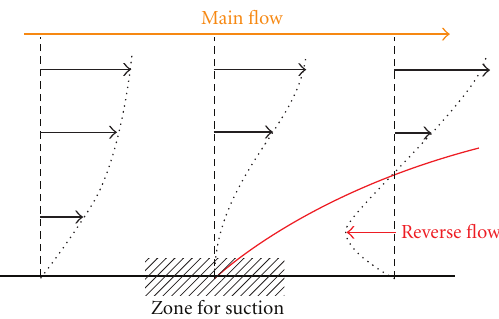
Figure 15: Location of suction—2D